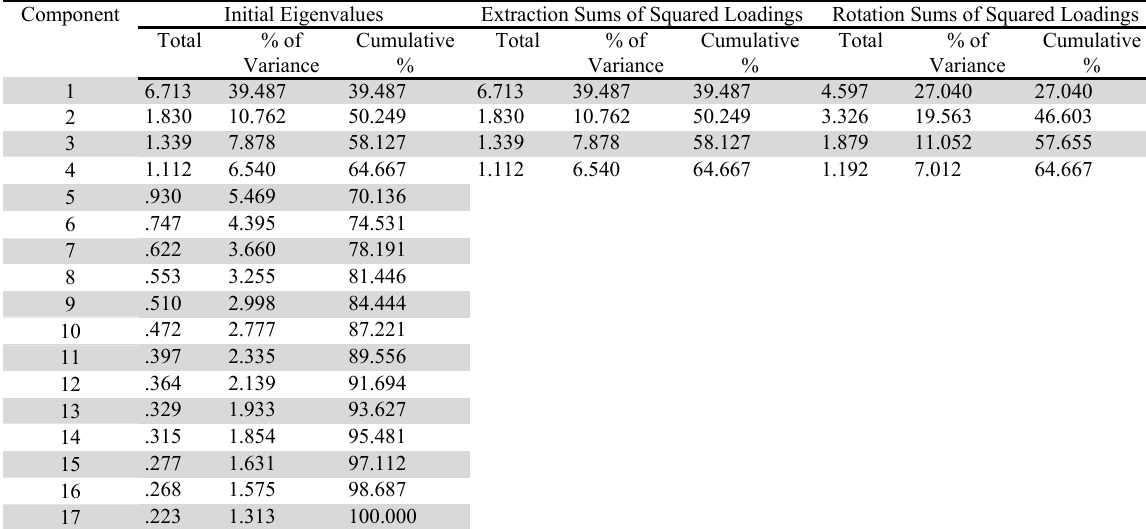
Total Variance Explained Component Initial Eigenvalues Extraction Sums of Squared